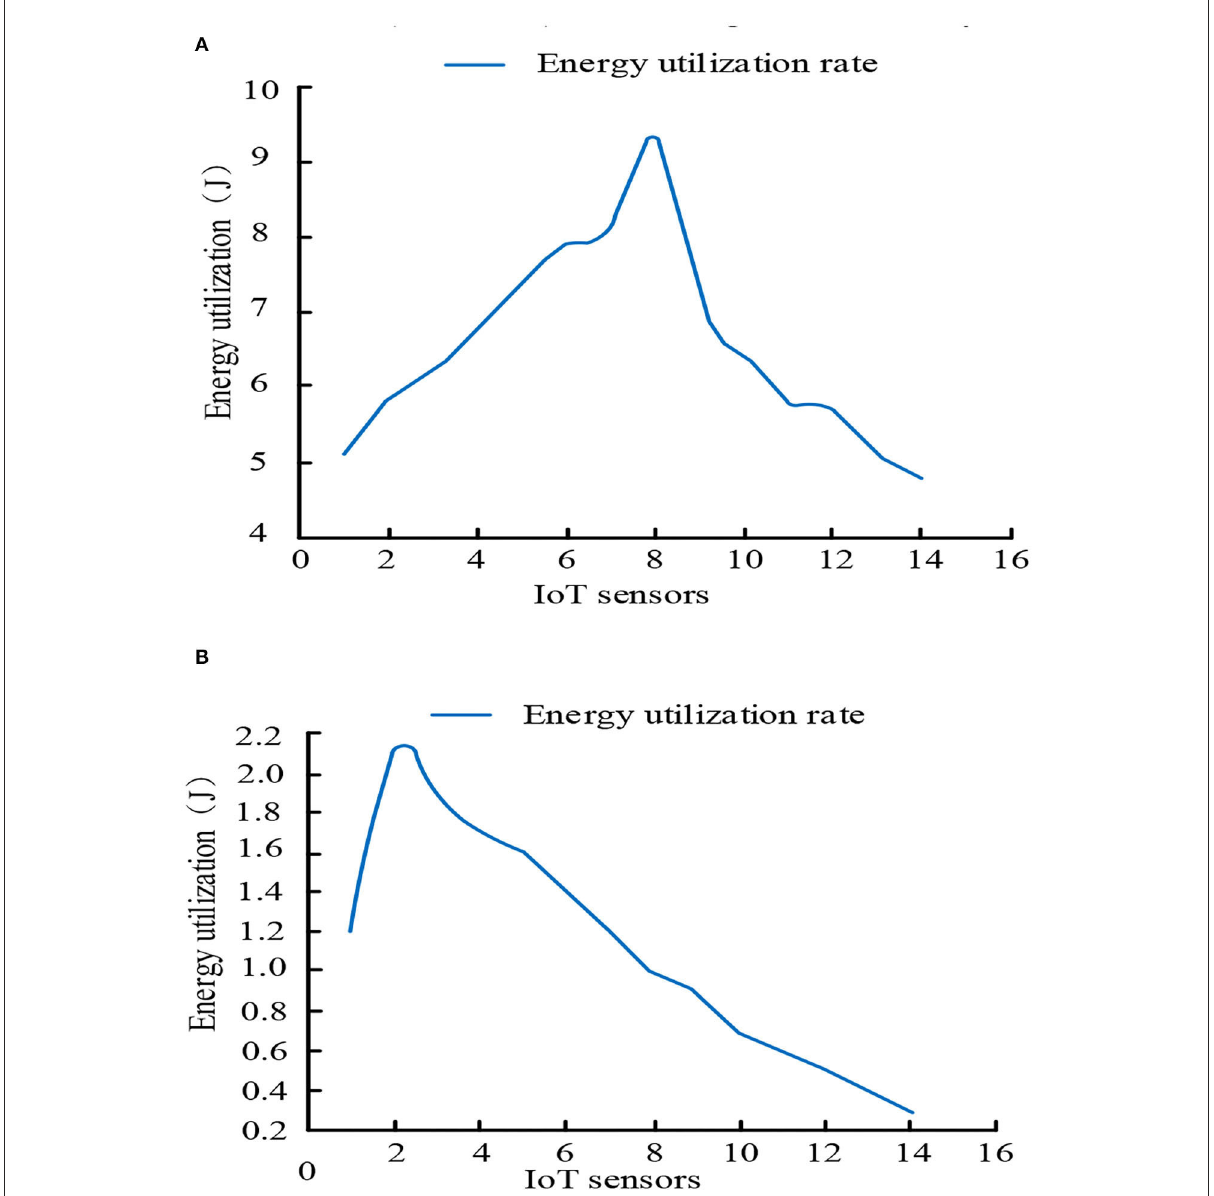
FIGURE7 Comparative analysis of energy utilization between Im-HMS system and UCD system. (A) Energy utilization analysis of the existing UCD system. (B) Energy utilization analysis of the proposed Intelligent m-Health monitoring system